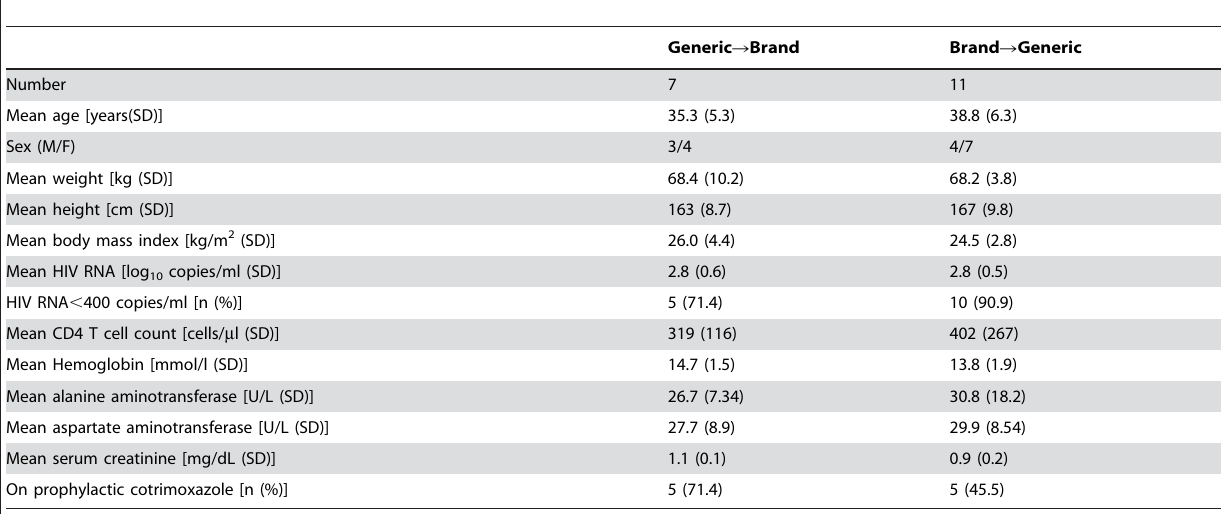
Table 1. Baseline characteristics of participants according to randomization